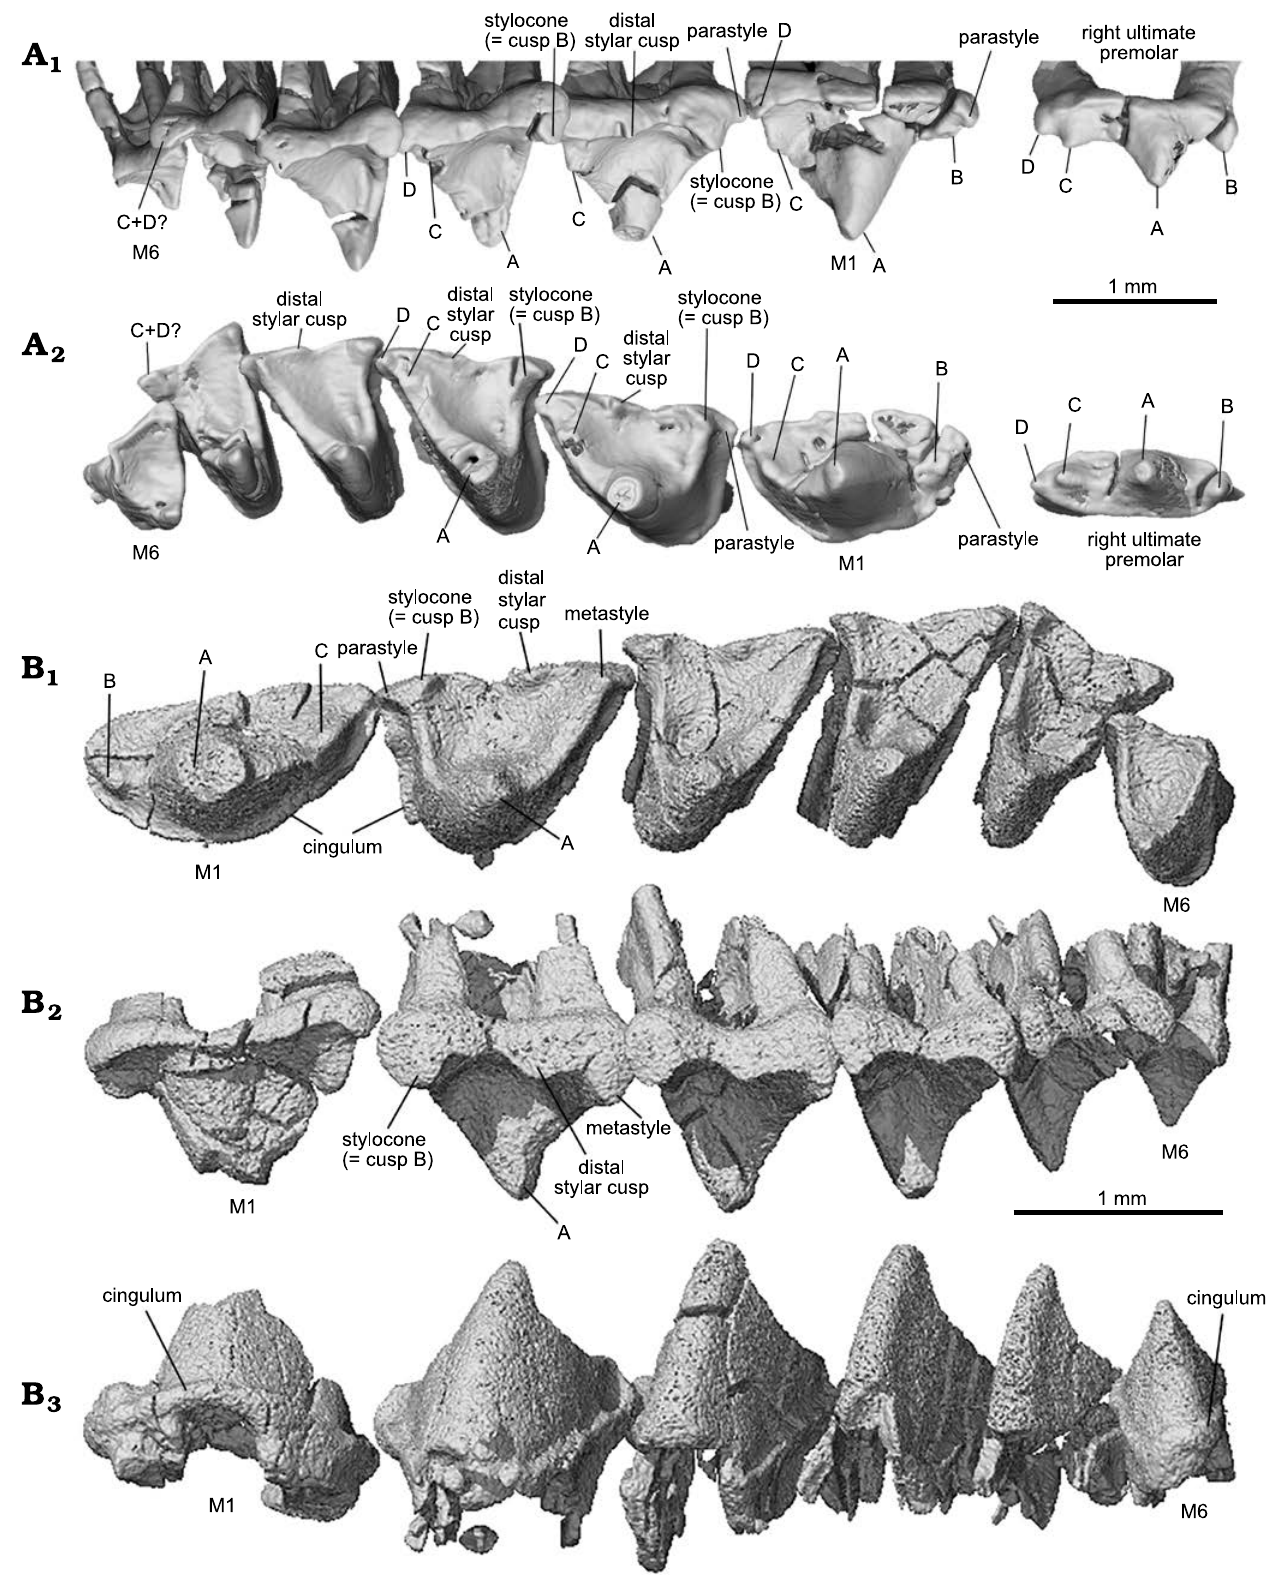
Fig. 4. Upper molars of the trechnotherian mammal Lactodens sheni Han and Meng, 2016, from Aptian, Lower Cretaceous Jiufotang Formation, Caoyang City, Liaoning Province, China. A . Holo type (HG-M016) from Shangheshou area; right ultimate premolar and M1–M6 in buccal (A 1 ) and occlusal (A 2 ) views, showing the corresponding cusps on different teeth. B . ZGY0053 from Dapingfang; left upper molars (M1–M6) in occlusal (B 1 ), buccal (B 2 ), and lingual (B 3 ) views. Image in B 3 is horizontally flipped for convenience of